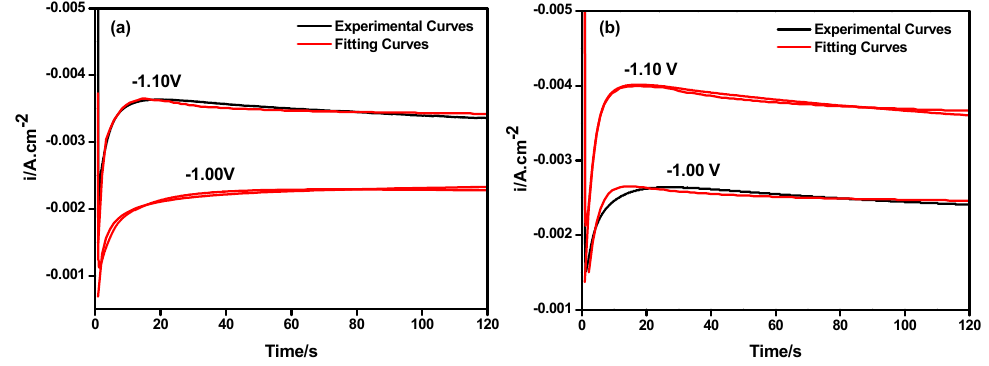
Figure 6. Experimental chronoamperometry curves and non-linear fitted theoretical plots: ( a ) Ni; and ( b ) Ni-Y 2 O 3 , T = 40 °C, and pH = 4. Table 2. The kinetic parameters calculated by Equation (6).